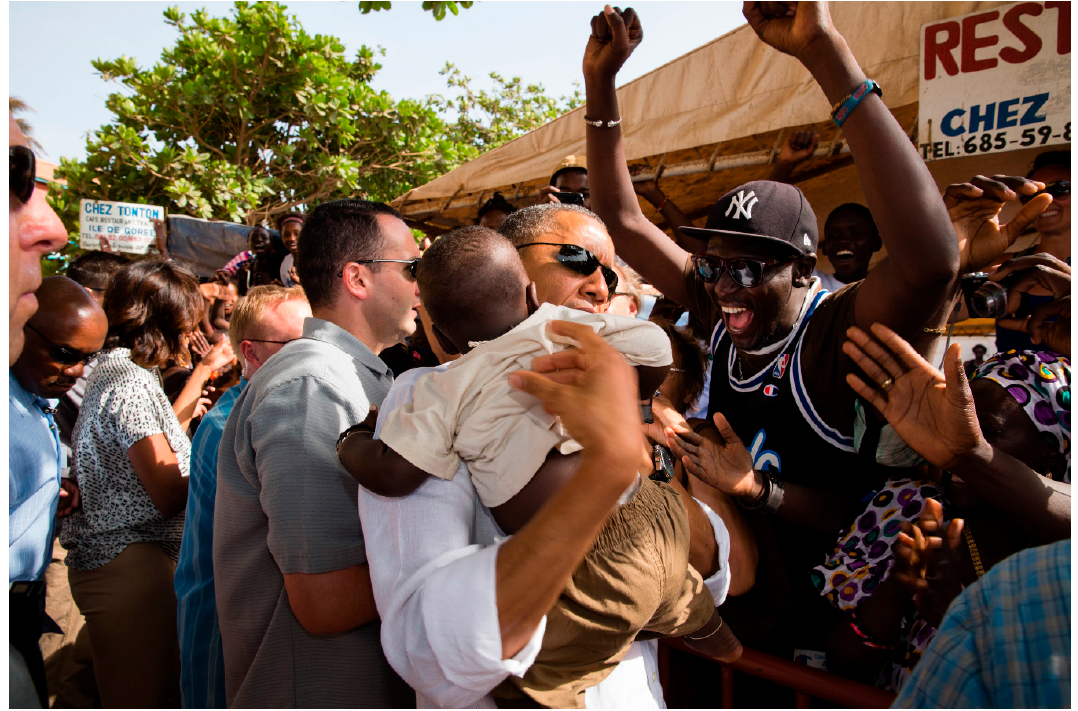
Figure 10. Barack Obama Greeted by Gorée Islanders. (Official White House photo by Pete Souza).